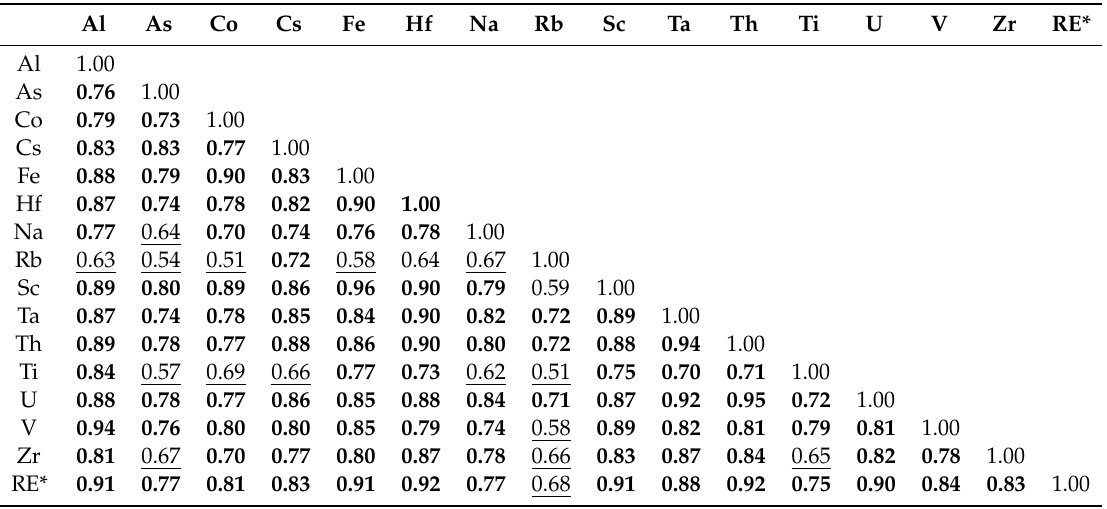
Table A1. Matrix of correlation coe ffi cients ( n = 216), a group of 16 selected principally natural distributed elements).